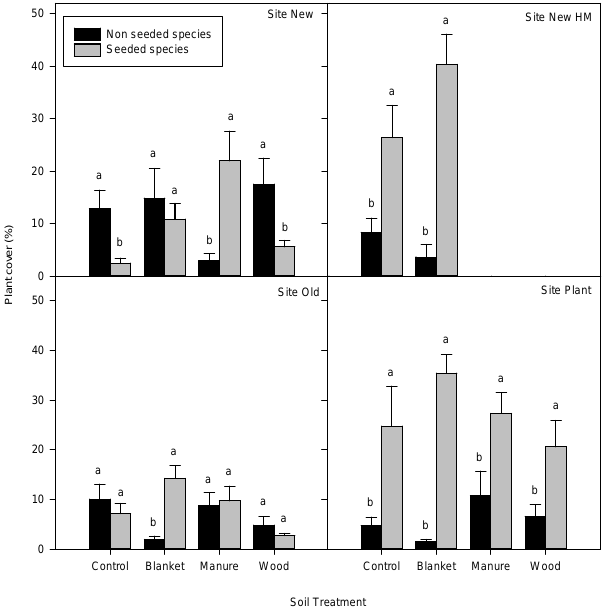
Fig. 3. Mean percent plant cover of seeded and non-seeded species in 2009. Letters indicate significant differences between plant cover Figure 3. Mean percent plant cover of seeded and non-seeded species in 2009. Letters of seeded and non-seeded species of the same treatment within a indicate significant differences between plant cover of seeded and non-seeded site. Bars indicate standard error. species of the same treatment within a site. Bars indicate standard error.